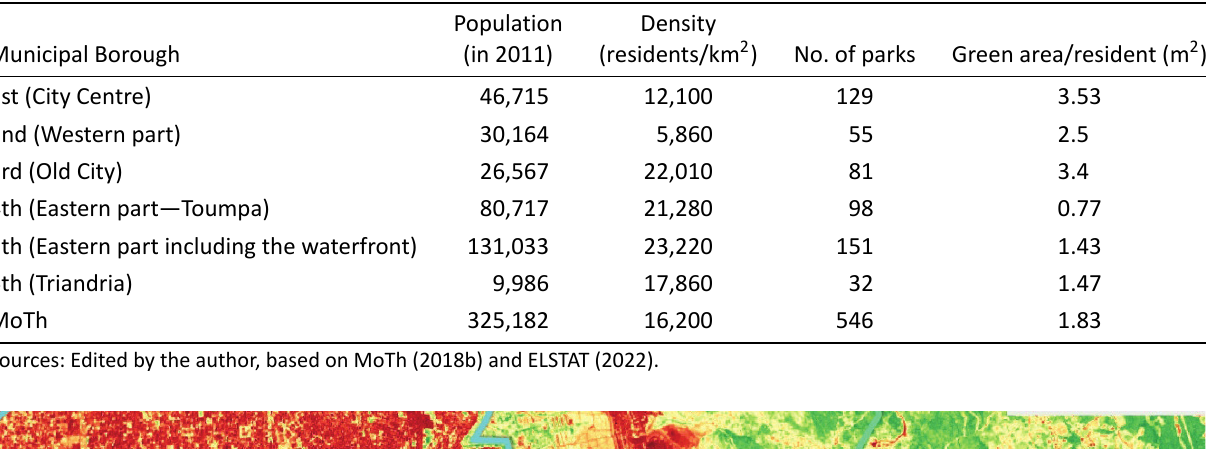
Urban Planning, 2023, Volume 8, Issue 1, Pages